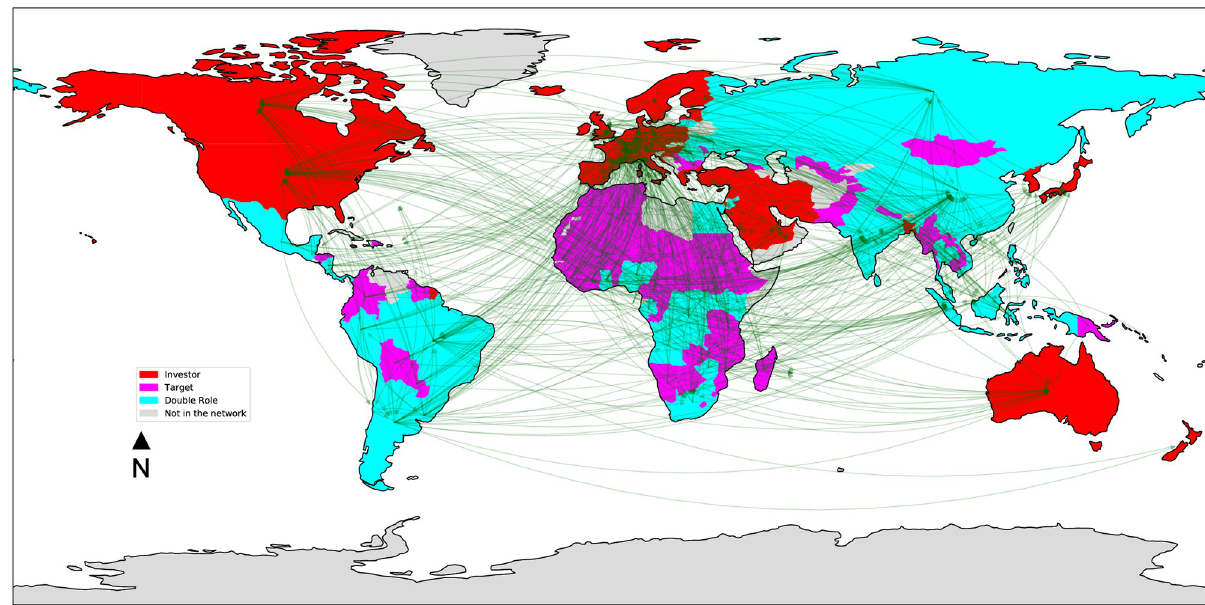
Fig 3. The multi-sector land trade network, where countries are colored based on their role: Source nodes/pure investors (red), sink nodes/pure targets (magenta), double role countries (cyan). Countries colored in grey are absent from the network.